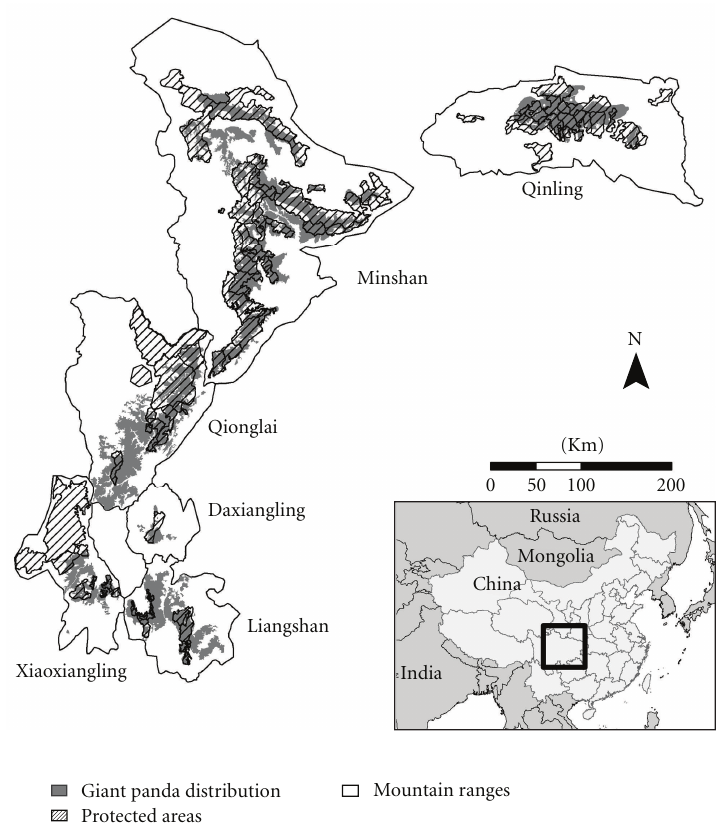
Figure 1: Current giant panda distribution, protected areas, and mountain